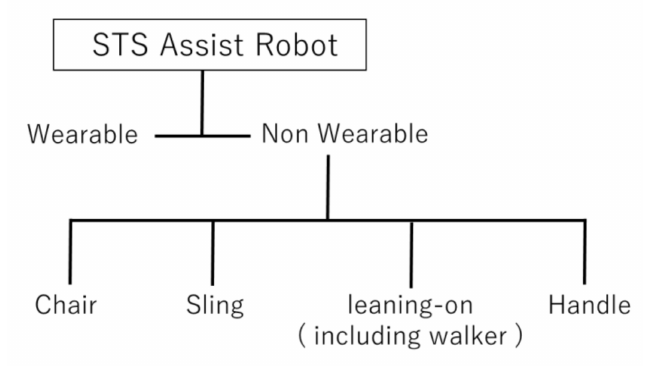
Figure 2. Categorization of sit-to-stand (STS) assistance robots.